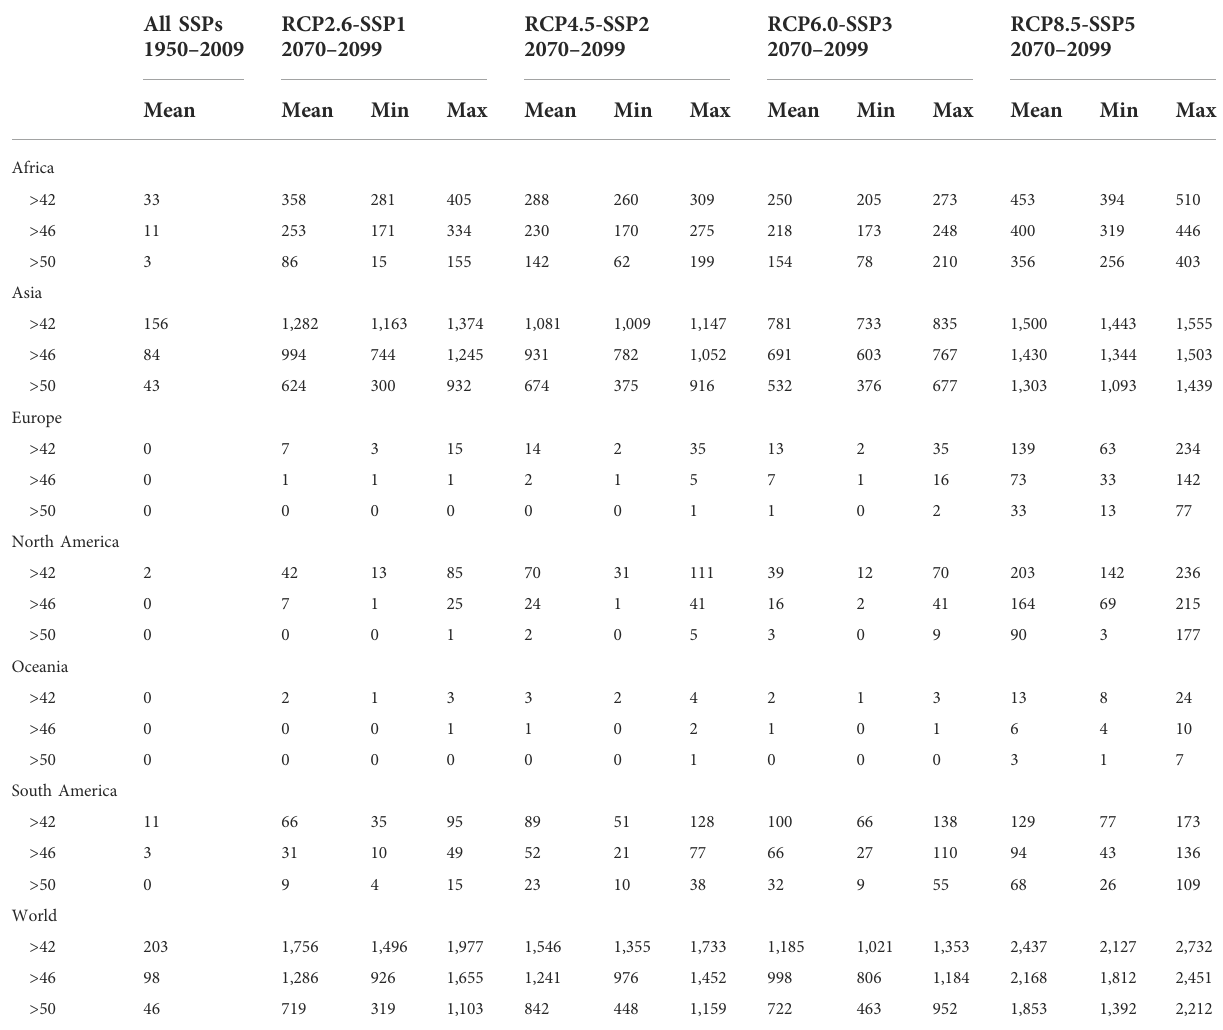
TABLE 5 Urban sensitive population exposed to extreme heatwaves by region. This table presents the mean and range of urban residents that are sensitive to heat ( < 5 and > 64 years of age) and projected to be exposed to 15-day heatwaves of > 42 ° C. The data are presented by region and for the